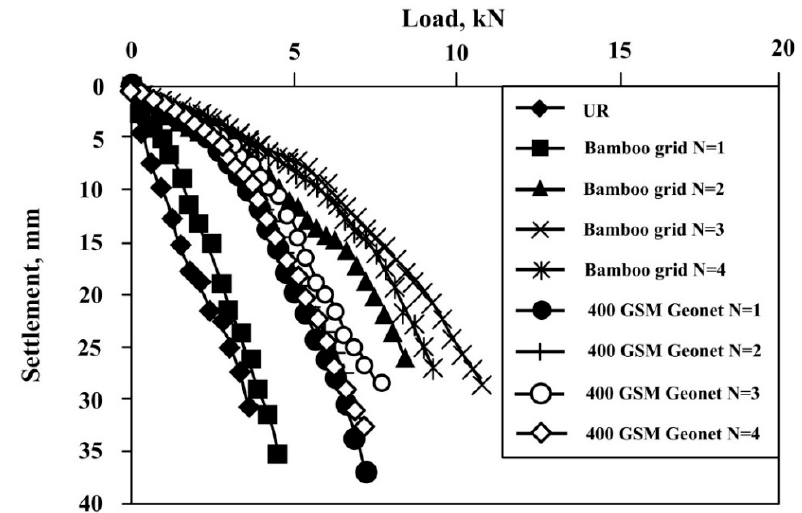
Figure 15. Comparison of the load settlement behaviour of bamboo-grid-reinforced soil and coir geonet (modified from Mathew and Sasikumar [35]).